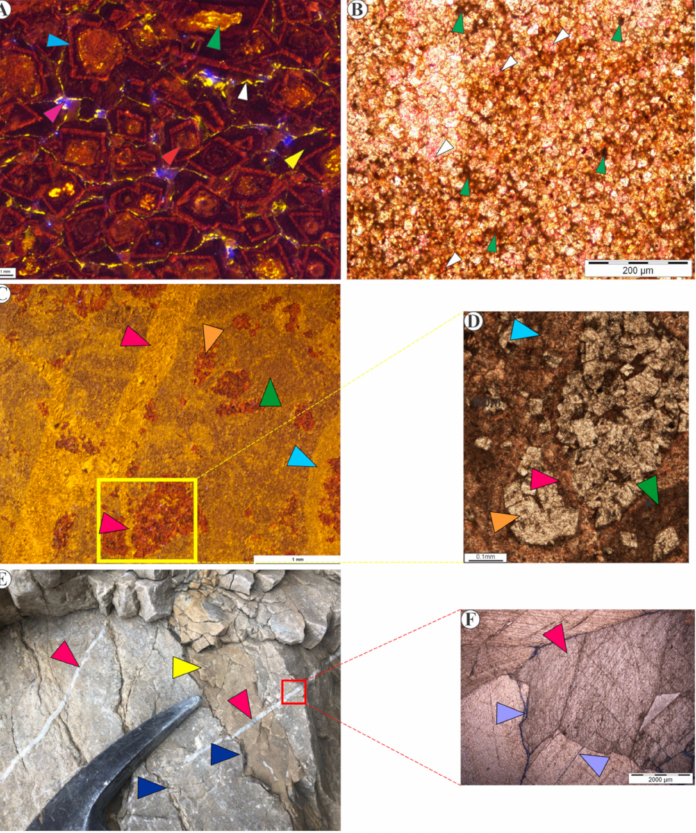
Figure 6. ( A , B ) CL image and photomicrograph indicates that the CC-II (white arrow) is selectively replacing the cloudy core (red arrow) of the already formed dolomite rhombs (light blue arrow). In most crystals the calcitization (CC-II) was observed along the edges of the replacive dolomite crystals and dolomite cements with yellow luminescence (white arrow). Pink arrow points to the intercrystalline porosity which has been recently occluded by a thin film of calcite cement (CC-II). Iron leaching as a product of calcitization (green arrows) lies in the intercrystalline pores spaces. Yellow arrow indicates overgrowth rims. ( C , D ) Photomicrograph of CL with enlarged plane polarized portion of the same view indicating partially replaced precursor limestone with inherited original components of the host limestone (blue and green arrow). The host limestone has been replaced by fabric preservative replaced dolomites (RD-I and RD-II) (orange arrows) truncated by fracture filling calcite cement (CC-III) (pink arrows). ( E ) Dissolution enlarged longitudinal vug in the partially replaced limestone has been filled by saddle dolomite (yellow arrow), enveloped by stylolites (dark blue arrows). Saddle dolomite and the partially replaced limestone is cross-cut by late-stage calcite veins (CC-IV) (pink arrows). ( F ) Very coarsely crystalline cavity and fracture filling calcite cement (CC-IV) (pink arrow) in the studied formation. The purple arrows indicate intercrystalline and intracrystalline